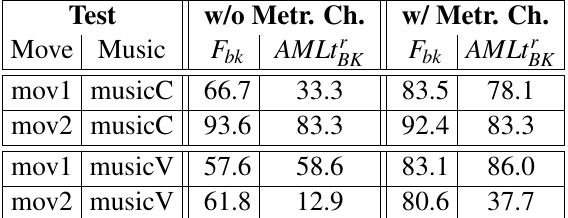
r bk and AMLt BK